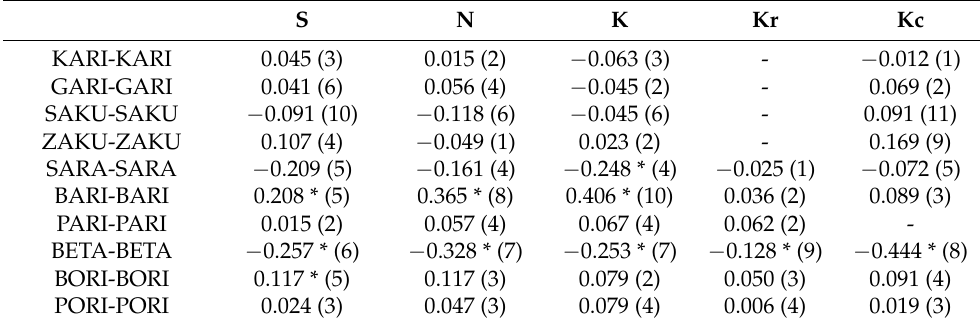
CLWD, average of individual centered liking while dominant scores. * p <